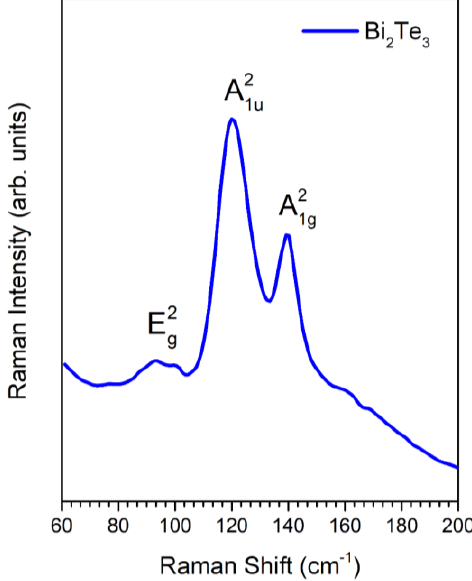
Figure 6. Raman spectrum of synthesized Bi 2 Te 3 film.